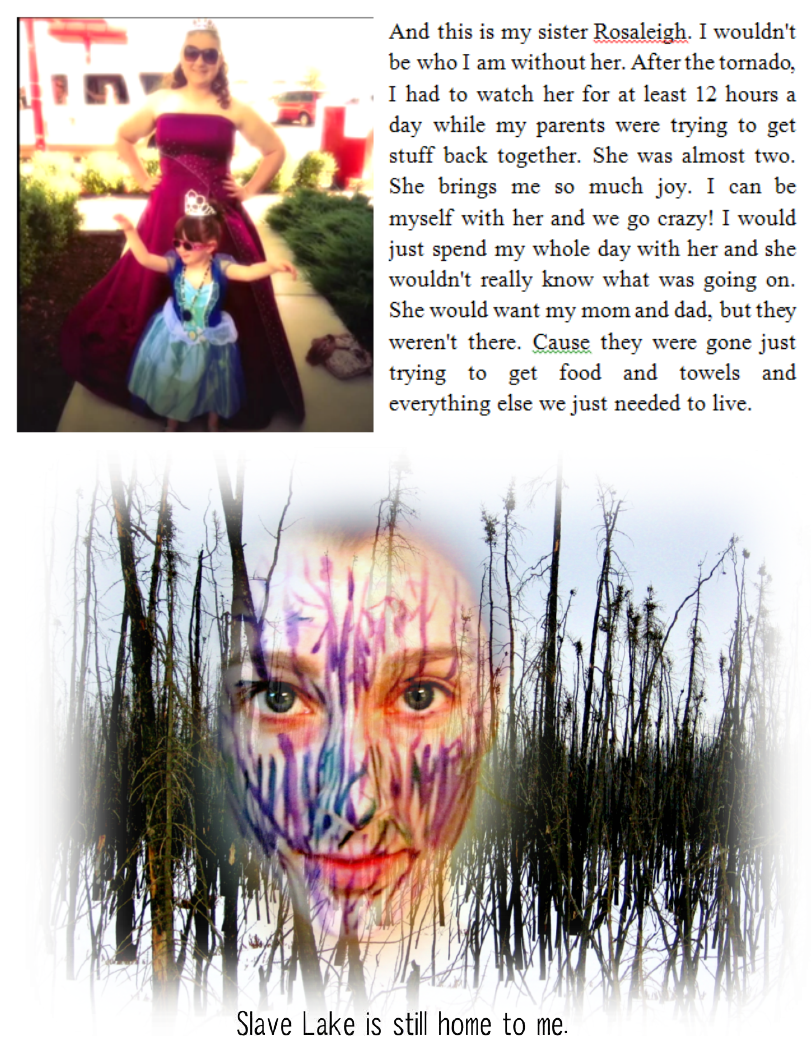
Figures 7 and 8: Still